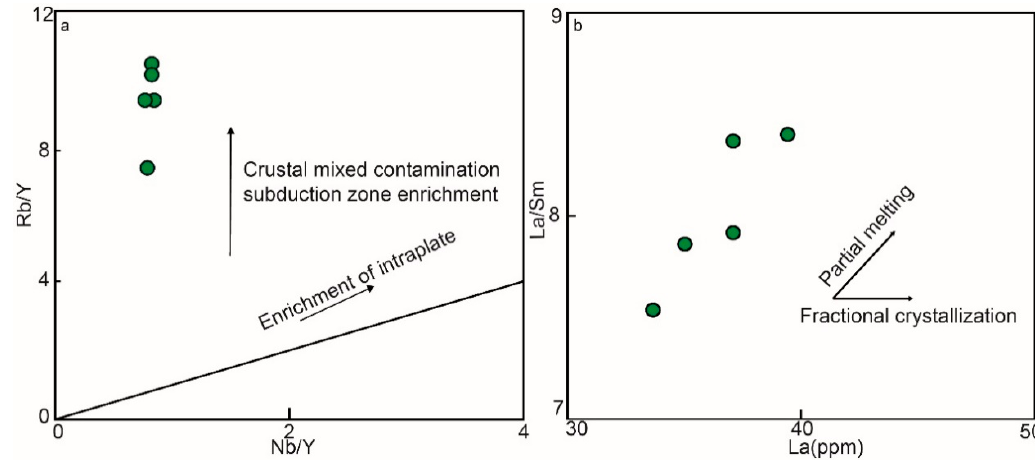
Figure 9. ( a ) Rb/Y–Nb/Y and ( b ) La/Sm–La for Hucunnan granodiorite. Figure 9. ( a ) Rb / Y–Nb / Y and ( b ) La / Sm–La for Hucunnan